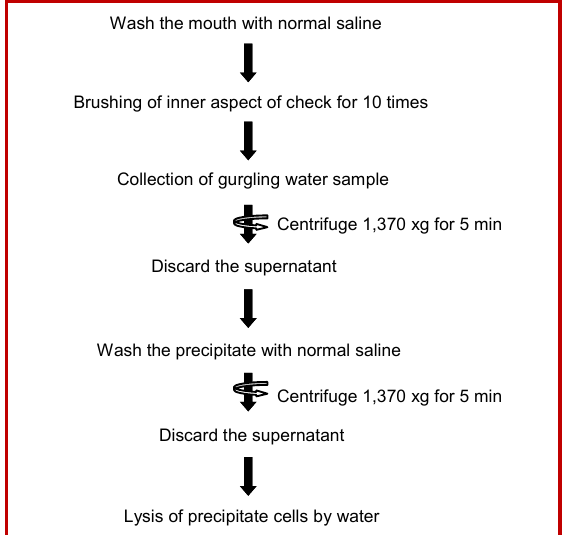
Figure 2: Steps of collection of buccal